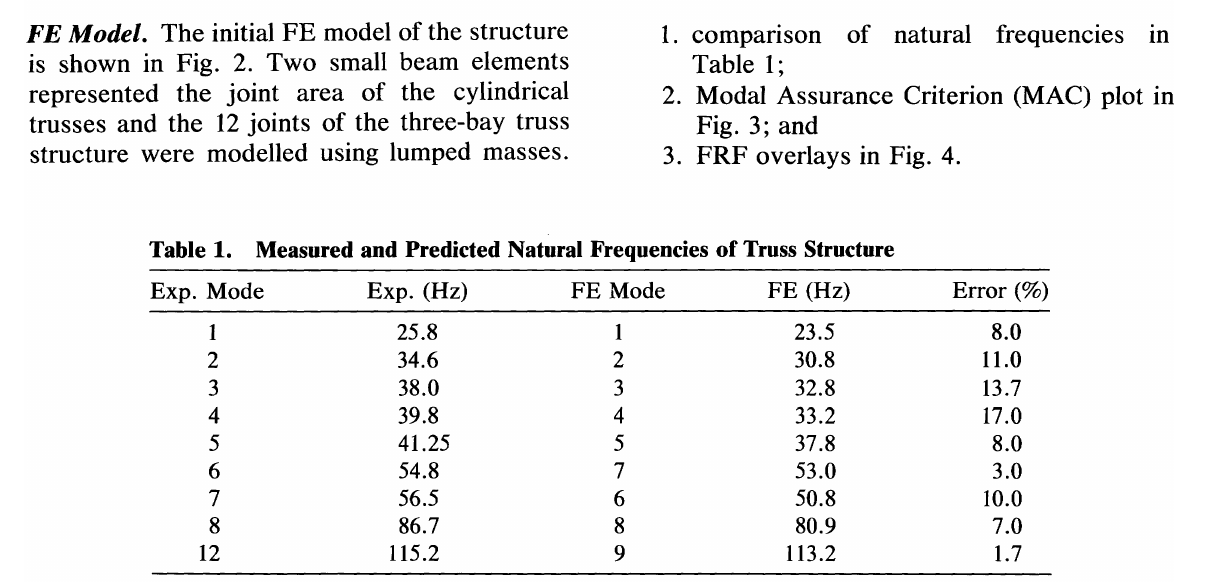
Table 1. Measured and Predicted Natural Frequencies of Truss Structure Exp.